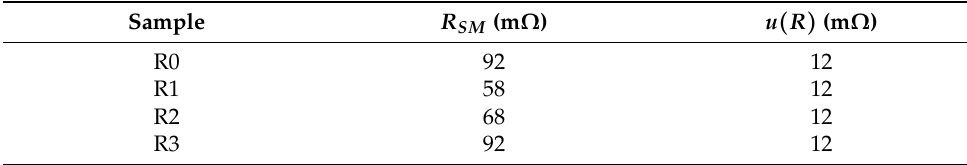
Table 3. Measurement